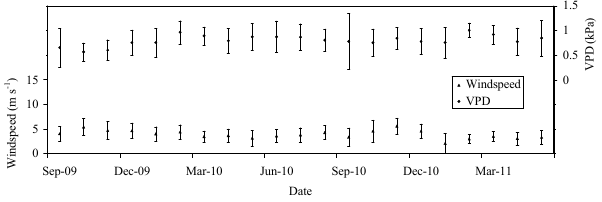
Fig. 4. Monthly average vapour pressure deficit and wind speed with standard deviation error bars measured at the Mfabeni Mire during daylight hours.